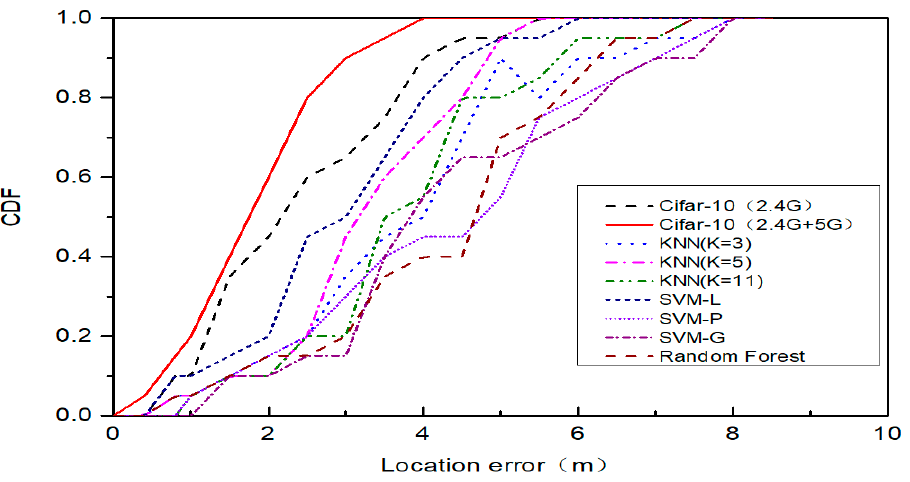
Figure 11. The cumulative distribution function of the location algorithm as Cifar-10, K nearest (KNN), support vector machines (SVM), and random neighbor (KNN), support vector machines (SVM), and random forest.